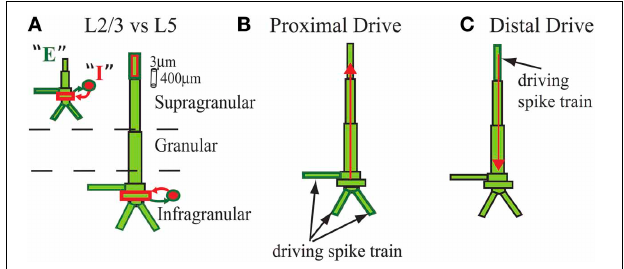
FIGURE 1 | Schematic of cells in model laminar cortical network. Multi-compartment excitatory pyramidal cells (E, green) and single compartment inhibitory basket cells (I, red) shown for cells with somata in supragranular L2/3 and infragranular L5 (E and I labeled for L2/3 cell but represented similarly for L5). Rectangles denote compartments. Cylindrical scale bar marks 3 μ m diameter and 400 μ m length. Figure adapted from (Jones et al., 2007, 2009). (A) Lines between cell types denote GABA A -ergic synaptic connections from I cells (red) and AMPA-ergic synaptic connections from E cells (green) that terminated on somatic compartments. (B) In some simulations, all L5 pyramidal cells received identical subthreshold proximal input, modeled as AMPA-ergic excitatory postsynaptic currents (EPSCs) that were delivered simultaneously to three compartments in each cell, as shown. (C) In some simulations, all L5 pyramidal cells received identical subthreshold distal input, also AMPA-ergic, and delivered to distal compartment of apical dendrites. Red arrows illustrate examples of longitudinal intracellular current dipole induced by each